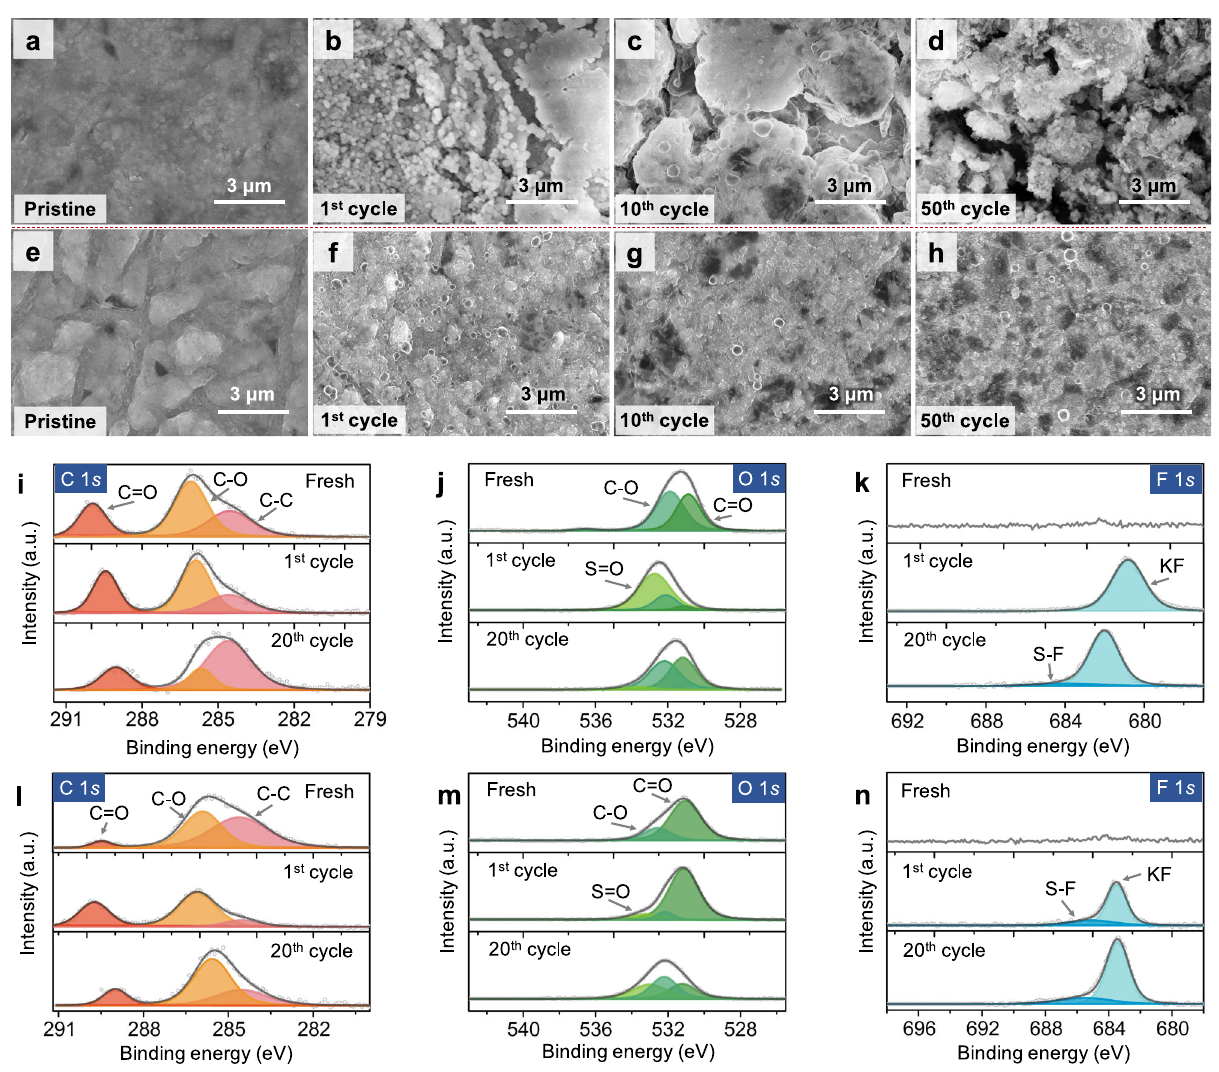
m O1 s and n F1 s fromsymmetriccellsbasedonMSCNF-Kanodesatdifferentcycle numbers (Fresh, after the 1 st charge, and after the 20 th charge). The ex situ elec- trodes were sampled at an intermediate state of potassiation. All electrochemical measurements were carried out at a temperature of